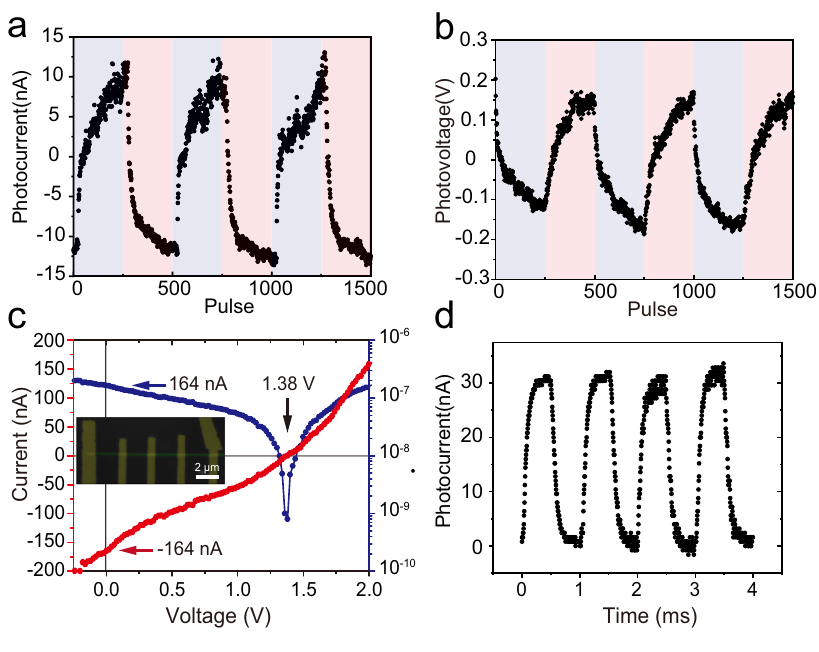
Fig. 2 | Continuous programmability and additivity of the photovoltaic effect. a Photocurrent programmed by voltage pulses. b Photovoltage programmed by